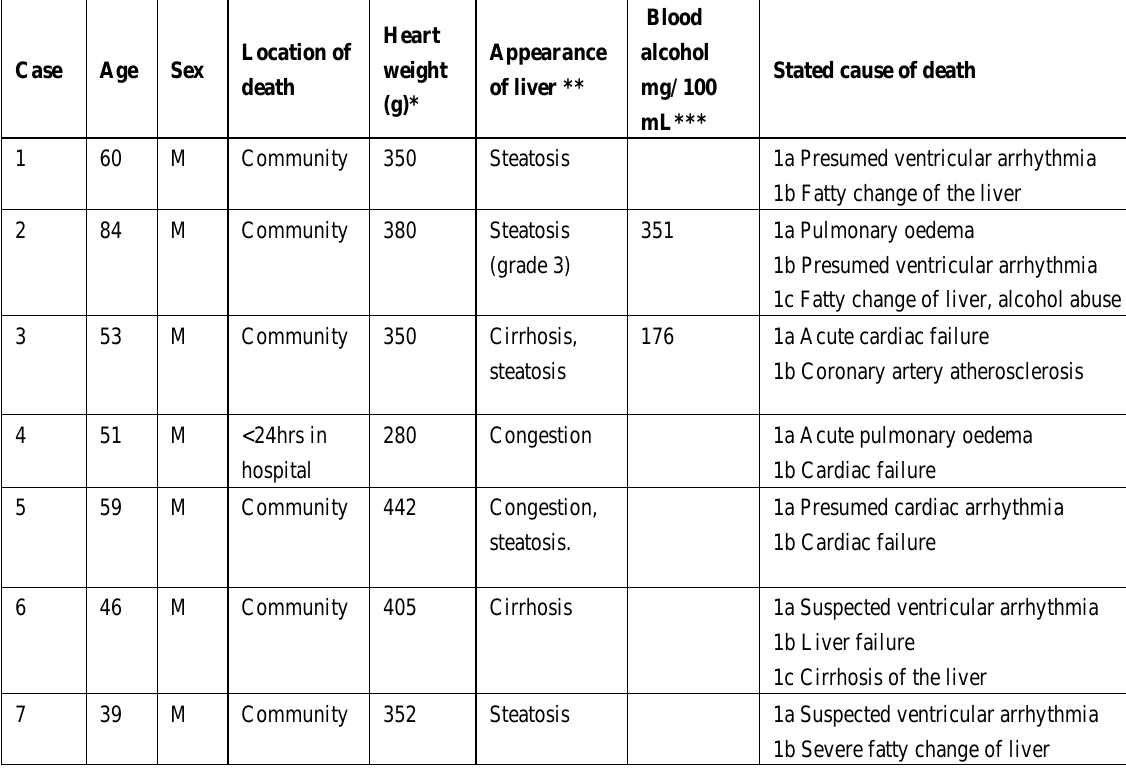
Table 2. Causes of death and post mortem findings in the seven cases of alcohol related